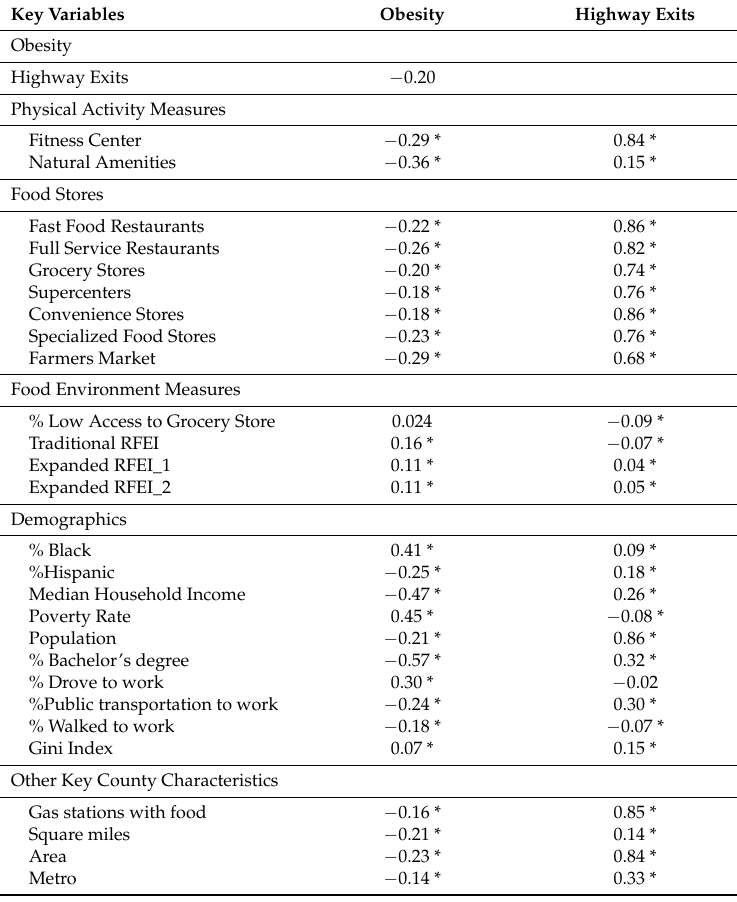
Table A3. Correlations between obesity rates, highway exits, food environment measures, physical activity, and